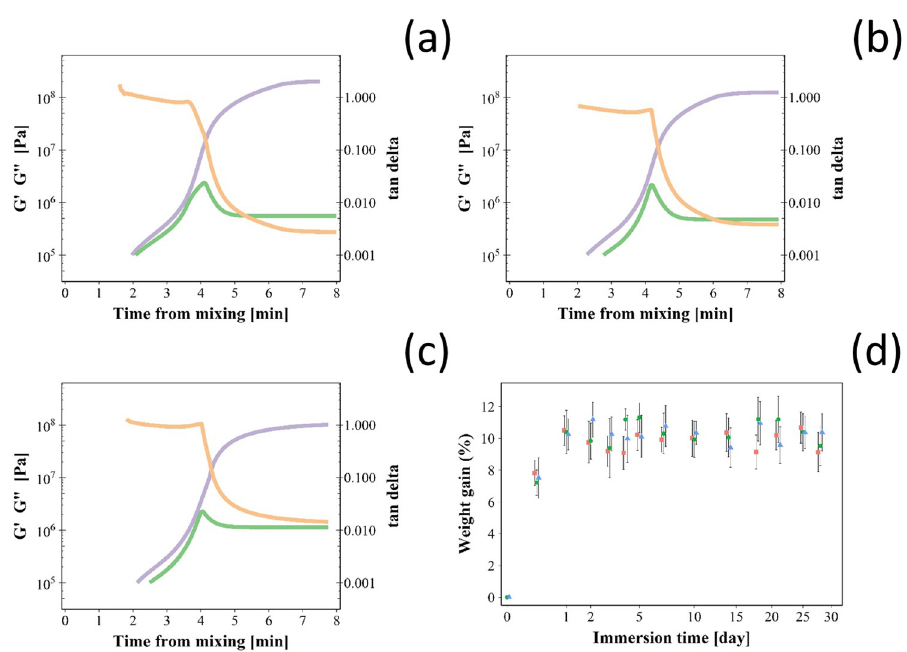
Fig 5. Bone cement settling. Time-dependent rheological measurements (tan δ in orange, storage modulus (G’) in violet and loss modulus (G”) in green) during curing for Cemex 1 bone cement (a), Cemex 1 containing chlorhexidine powder 3% w/w (b) and coated silica nanoparticles (c). (d) Water uptake for Cemex 1 bone cement (green), Cemex 1 containing chlorhexidine powder 3% w/w (violet) and coated silica nanoparticles (orange) during incubation in PBS buffer (mean ± SD, n = 3).